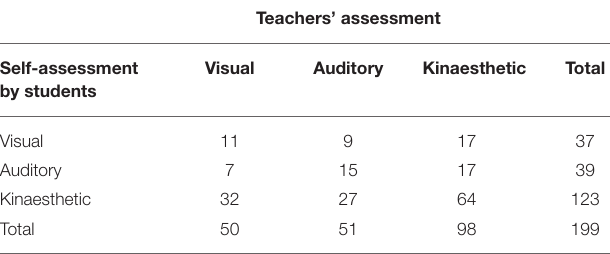
TABLE 1 | Crosstabulation of Learning Styles (LS) as measured by self-assessment by the students and by the assessment of